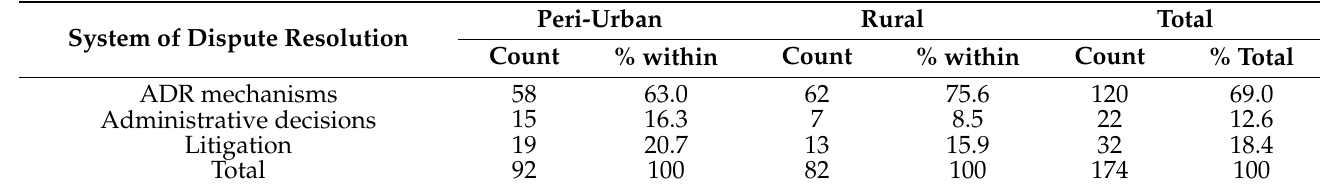
Table 6. Dispute resolution